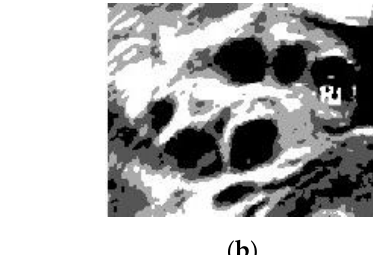
Figure 10. ( a ) Original ultrasound image, ( b ) ultrasound image after contrast enhancement, ( c ) ul- trasound image with median filter, and ( d ) ultrasound image after histogram equalization.